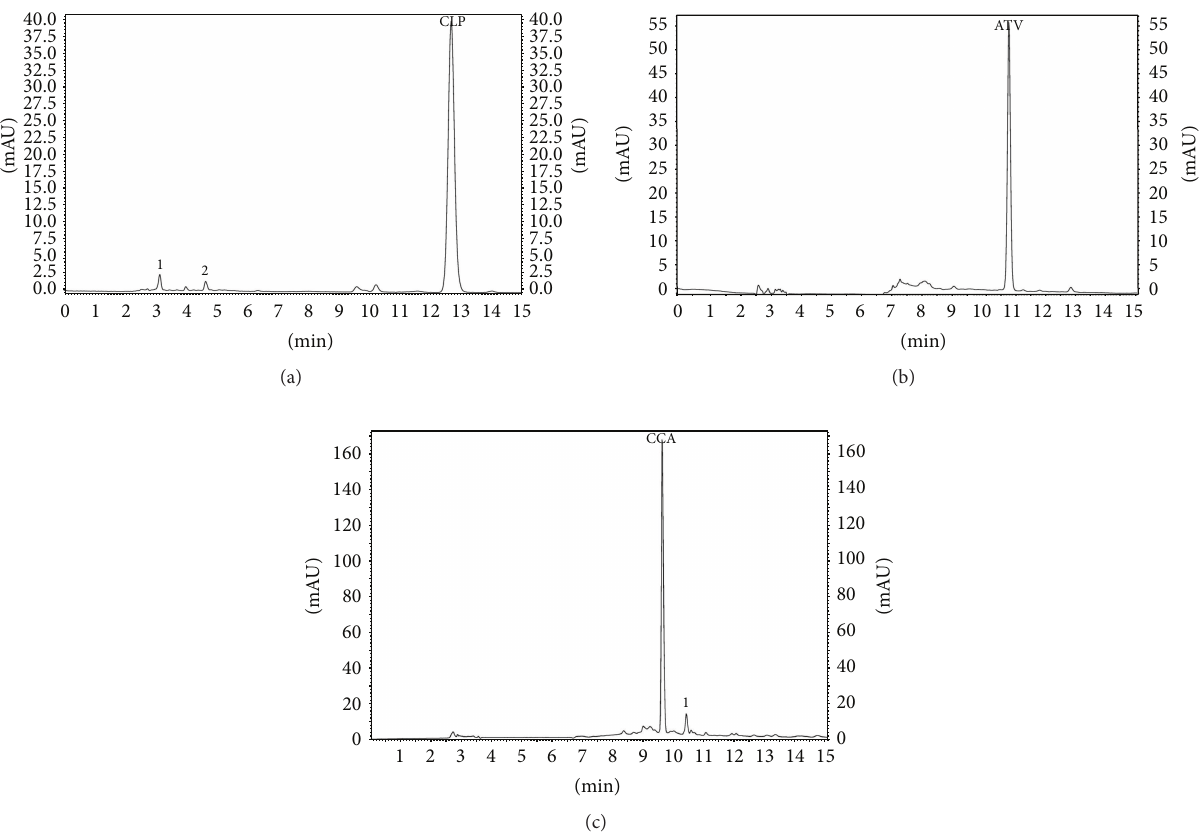
Figure 3: Chromatograms of clopidogrel bisulfate, its carboxylic acid metabolite, and atorvastatin calcium 25 𝜇 g ⋅ mL −1 in optimized mobile phase (1,2-impurities).